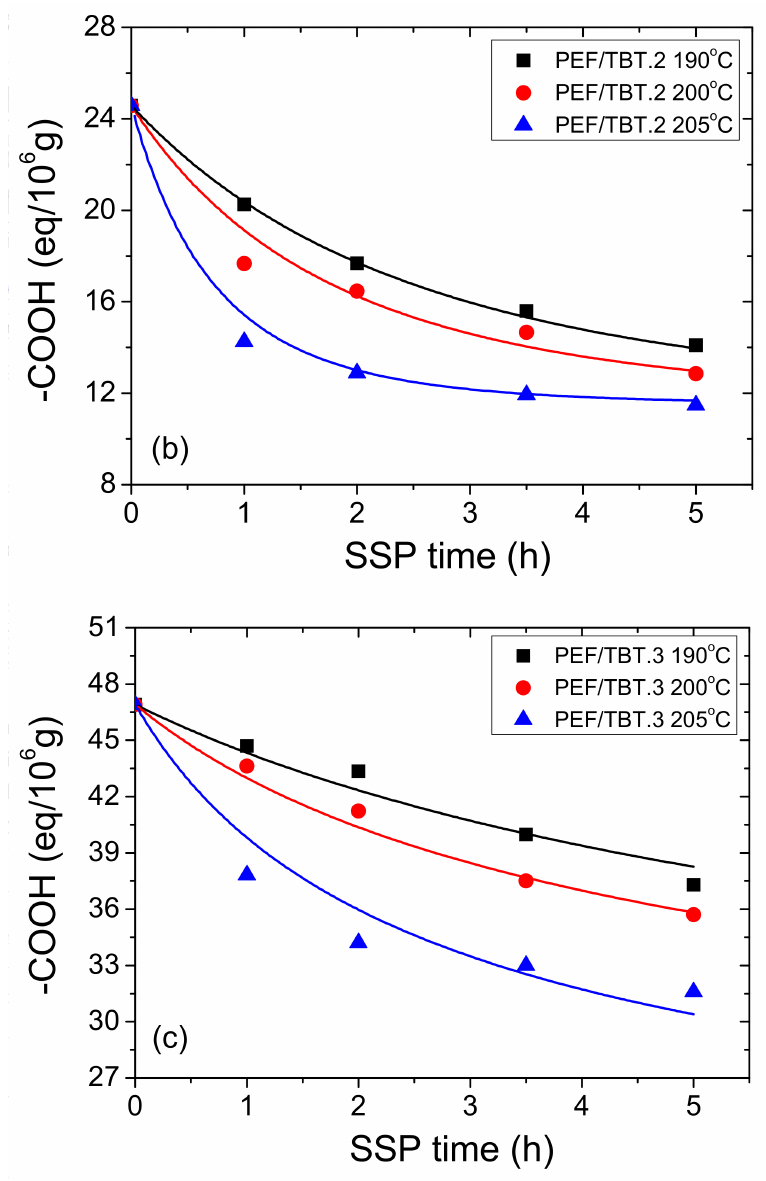
Figure 3. Variation of carboxyl end-groups with time during PEF/TBT.1 ( a ); PEF/TBT.2 ( b ); and PEF/TBT.3 ( c ) SSP at different temperatures. Continuous lines represent the theoretical kinetic model simulation